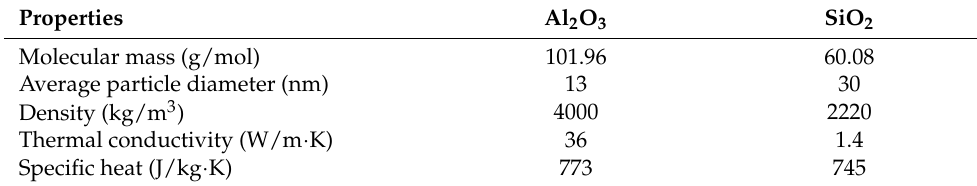
Table 1. Properties of the nanoparticles [37].